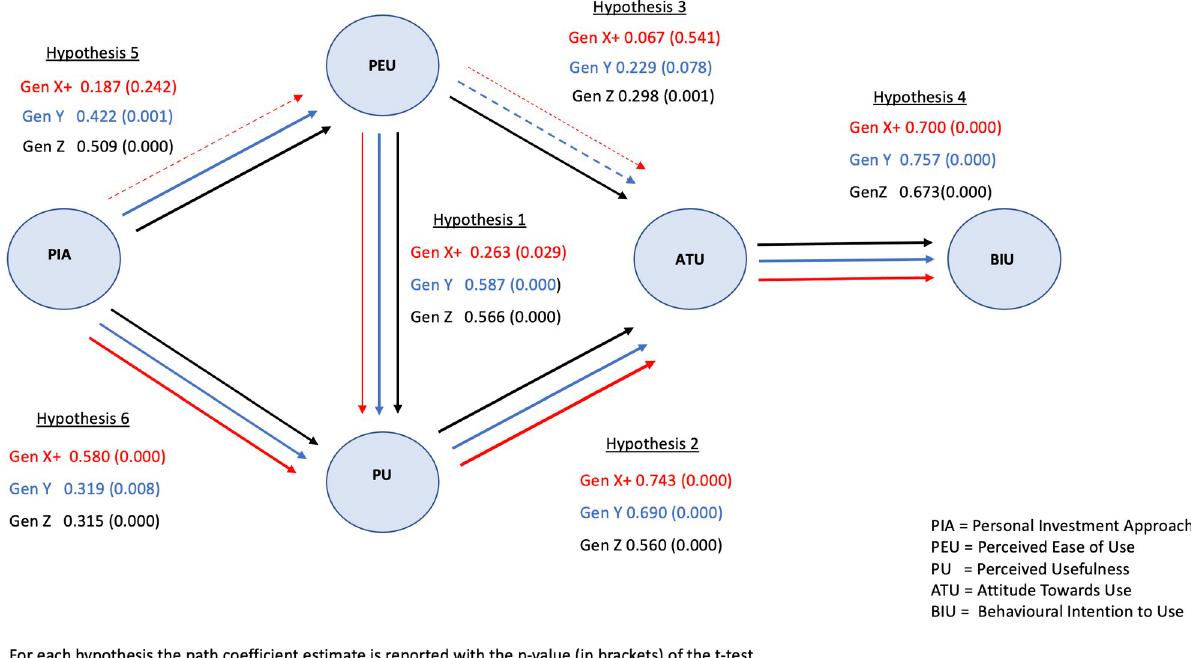
Fig 2. Technology acceptance constructs and causality links segmented by